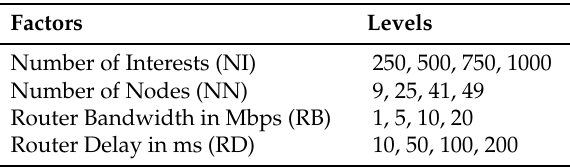
Table 1. Factors and the levels used in